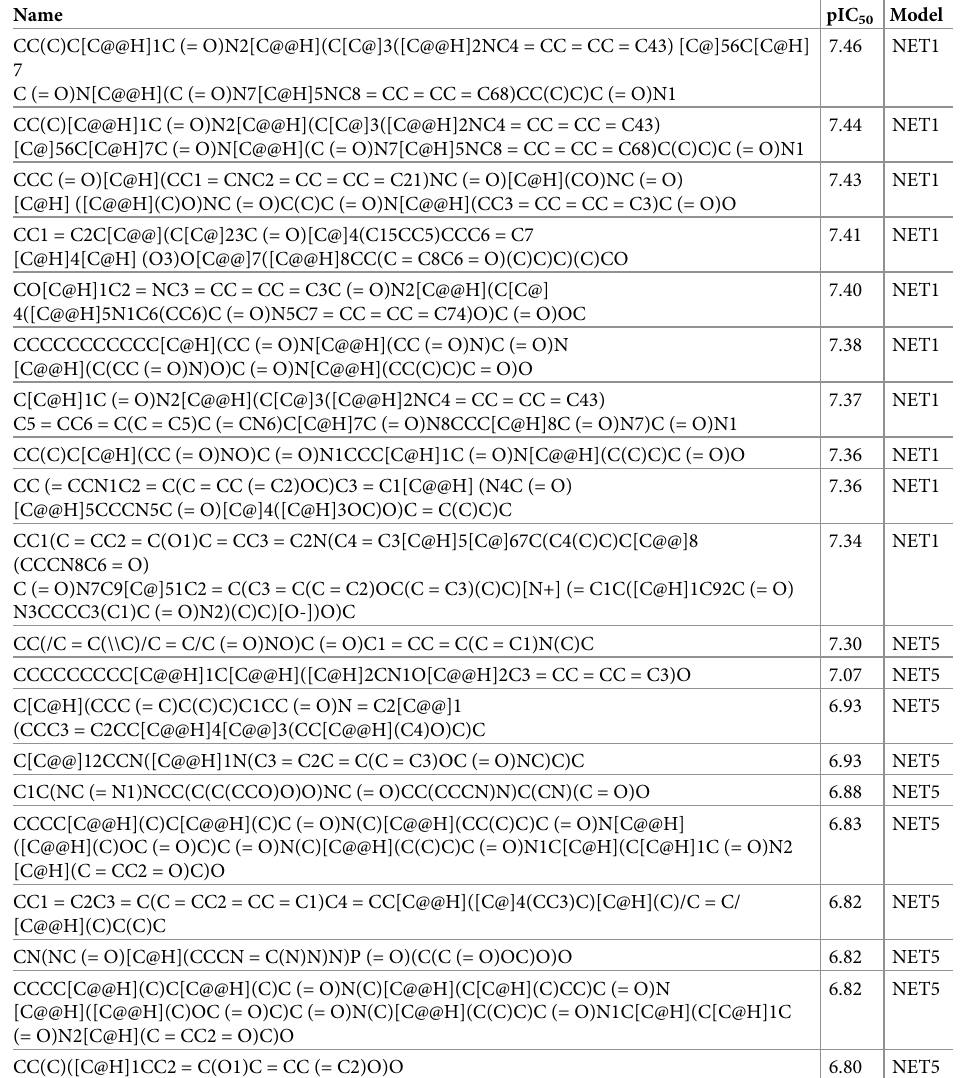
Table 3. SMILES of top 10 compounds screened using NET1 and NET5 model, ranked based on their predicted pIC 50